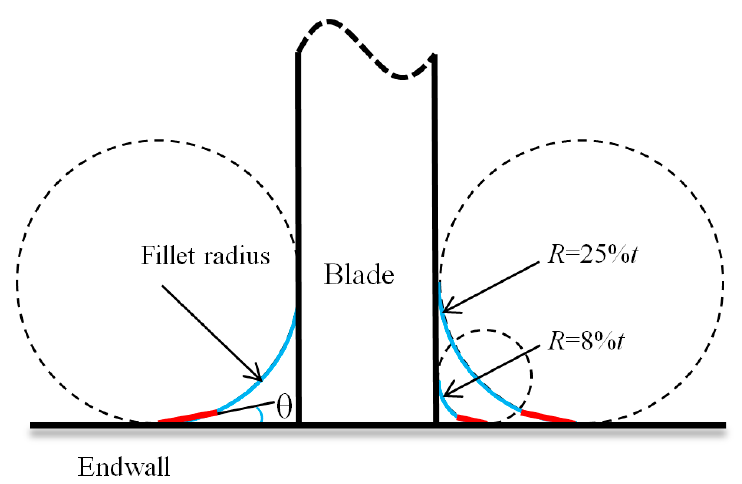
Figure 6. Design parameters: fillet radius and minimum angle.